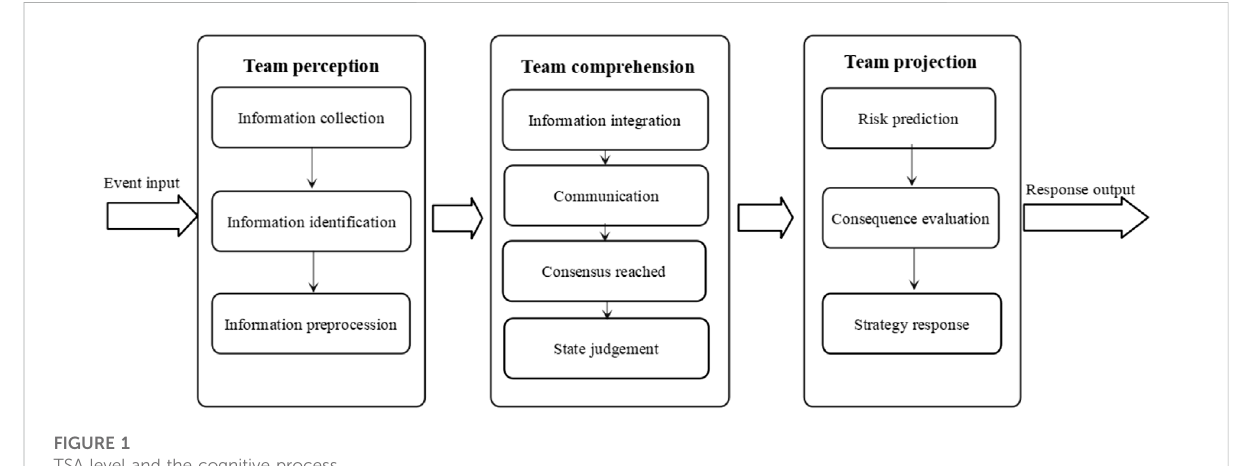
FIGURE 1 TSA level and the cognitive